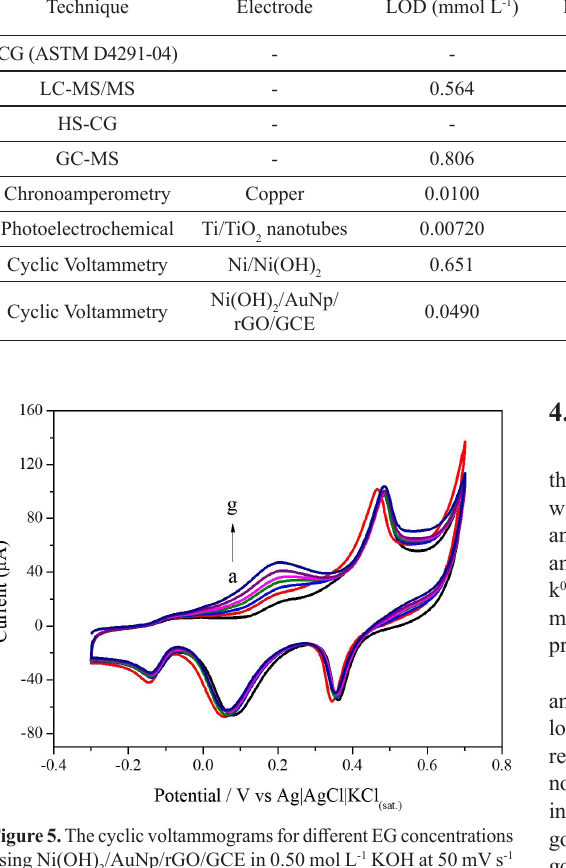
Table 2. Comparison of some analytical parameters for the proposed method with other methods found in the literature. Technique